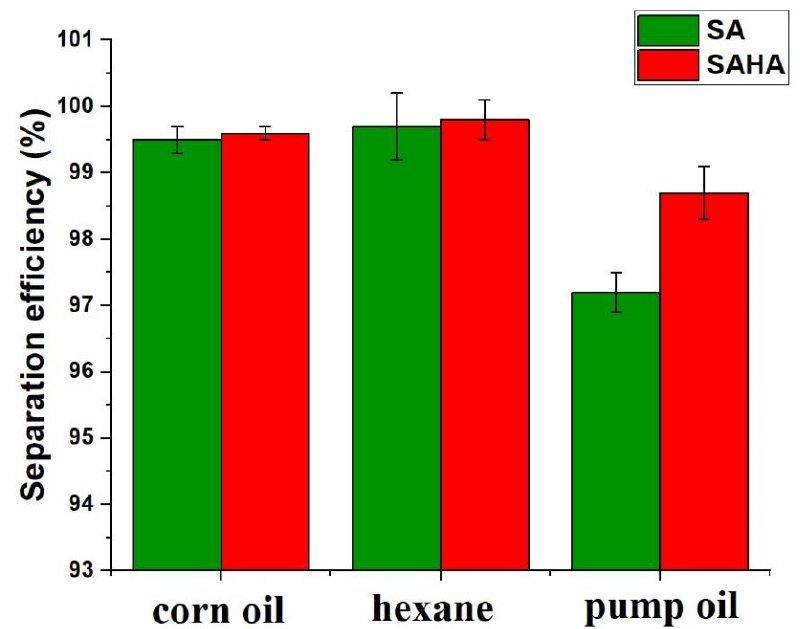
Figure 10. Oil / water separation e ffi ciency of the SA and SAHA aerogels for di ff erent Figure 10. Oil/water separation efficiency of the SA and SAHA aerogels for different solvents.